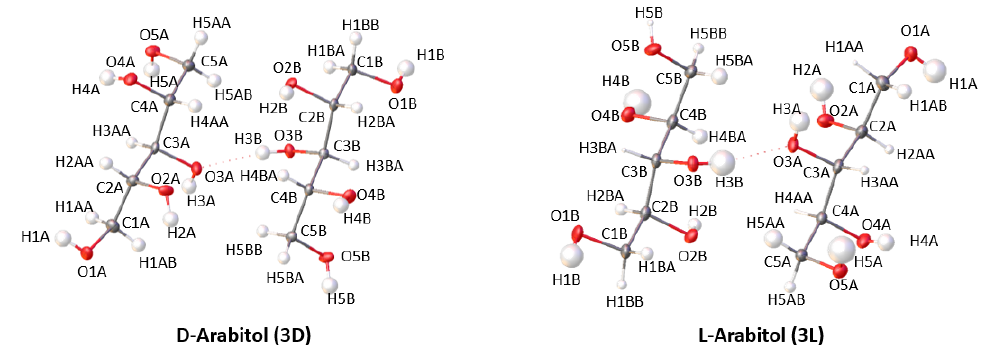
Figure 7. An ORTEP view of D-arabitol ( 3D ) and L-arabitol ( 3L ). Displacement ellipsoids are drawn at 50% probability level.